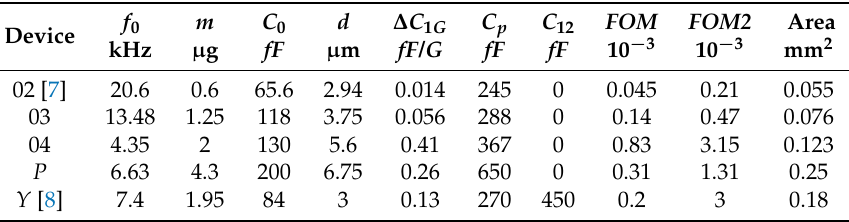
Table 8. Comparison of the FOM and area data of different